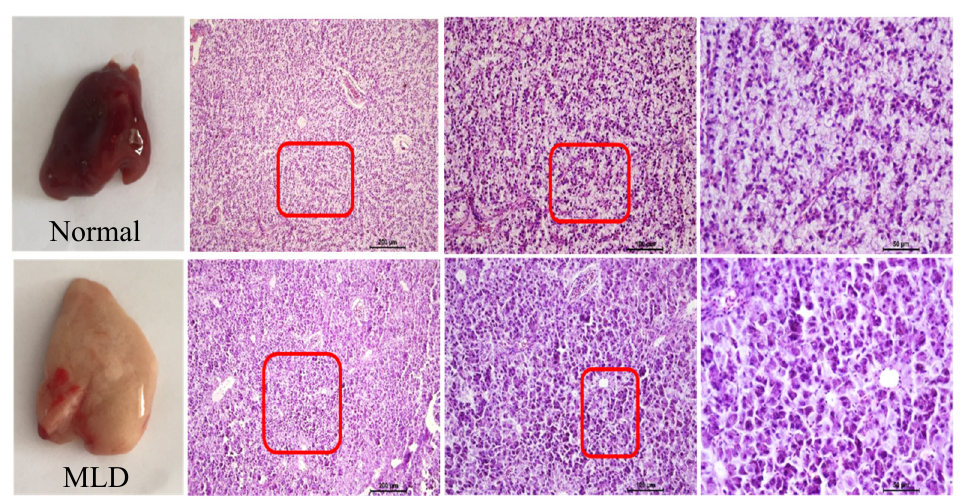
Figure 1. Liver histopathology, enlarged lipid droplets (marked with red boxes) were clearly observed in MLD group. (MLD: metabolic liver disease).